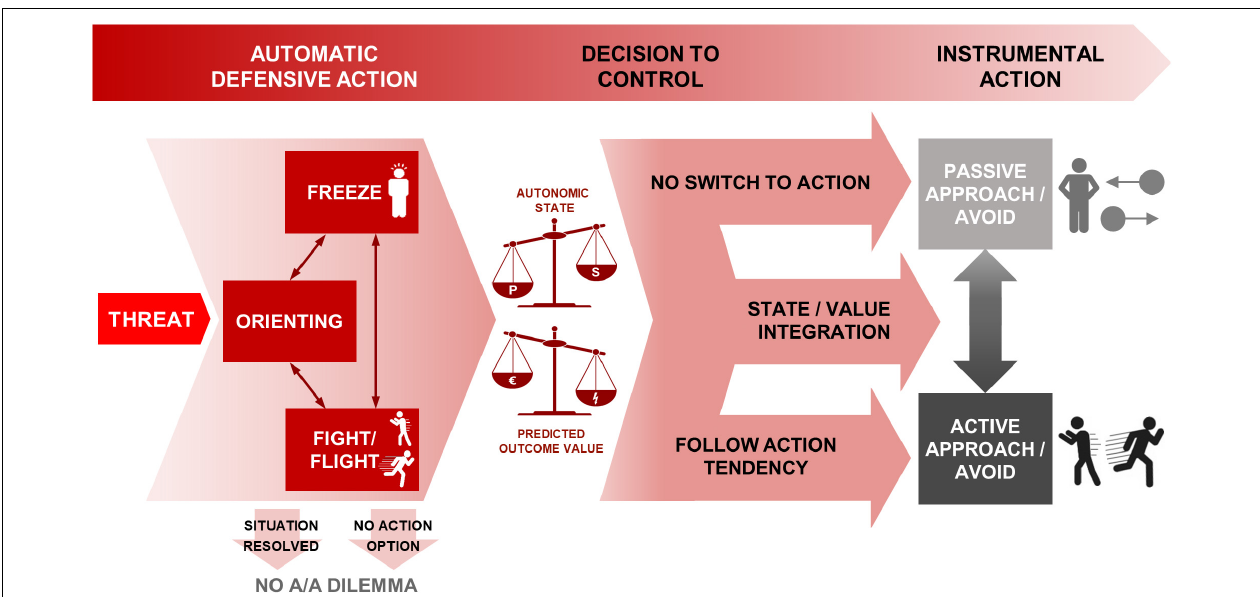
FIGURE 1 | Schematic of processes from threat appearance to instrumental action decisions under approach-avoidance conflict. The appearance of threat gives rise to automatic defensive reactions in the first instance, including orienting, freezing and fight/flight. The situation may resolve itself at this stage, or no instrumental actions may be available, shown in the arrows terminating in no A/A dilemma. Otherwise, freezing and fight/flight are associated with prepotent action tendencies. Of those, freezing could be continued into inaction (top arrow, resulting in passive approach or avoidance) and fight/flight into approach/avoidance behavior (bottom arrow) without the need to override the prepotent action tendency. However, a decision can be made to control the prepotent tendencies in favor of an anticipated reward-punishment outcome. Both the decision to control, and the subsequent behavior if control is exerted, are based on the two scales shown: the predicted outcome from the assessed reward-punishment balance, and the autonomic balance of parasympathetic and sympathetic states (where for example more freezing requires a larger shift in order to take active action—see section “Threat-Anticipatory Freezing Could Bias the Switch to Action” for further details). These are integrated through state/value integration (middle arrow) to determine the choice of action—passive or active behavioral mode, and approach or avoidance action. P, parasympathetic; S, sympathetic; A/A, Approach/Avoidance.